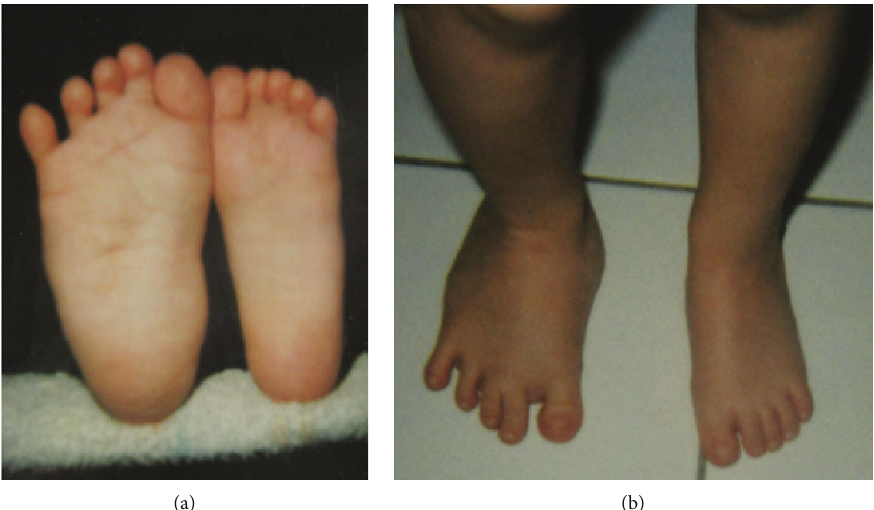
Figure 1: Photograph of the plantar (a) and dorsal (b) sides of the patient ’ s feet as a child (2 years), as provided by the parents.